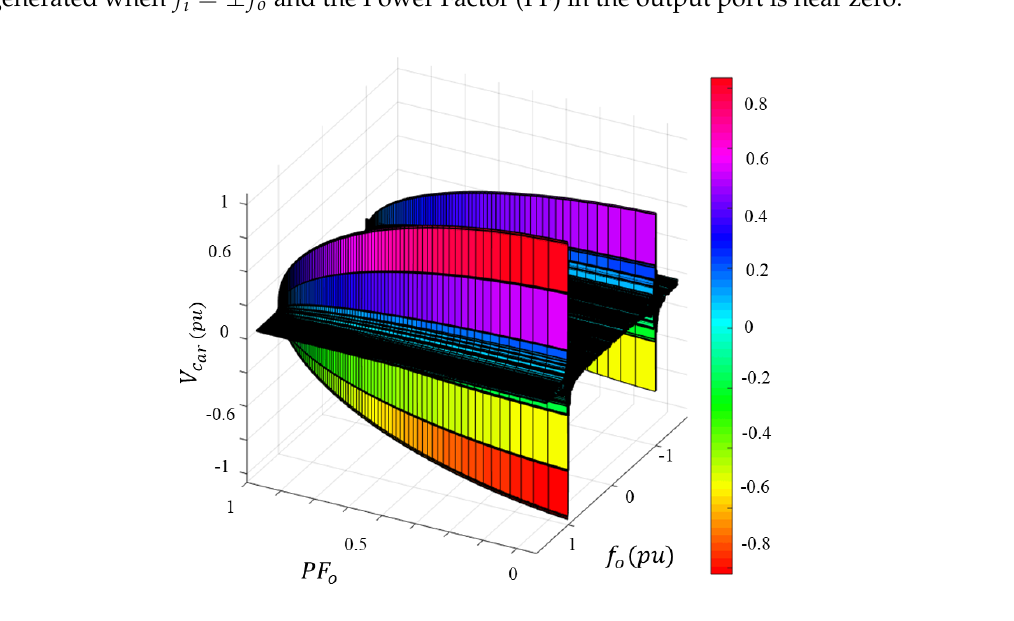
Figure 2. Cluster Capacitor Voltage (CCV) (pu) vs. PF o vs. f o